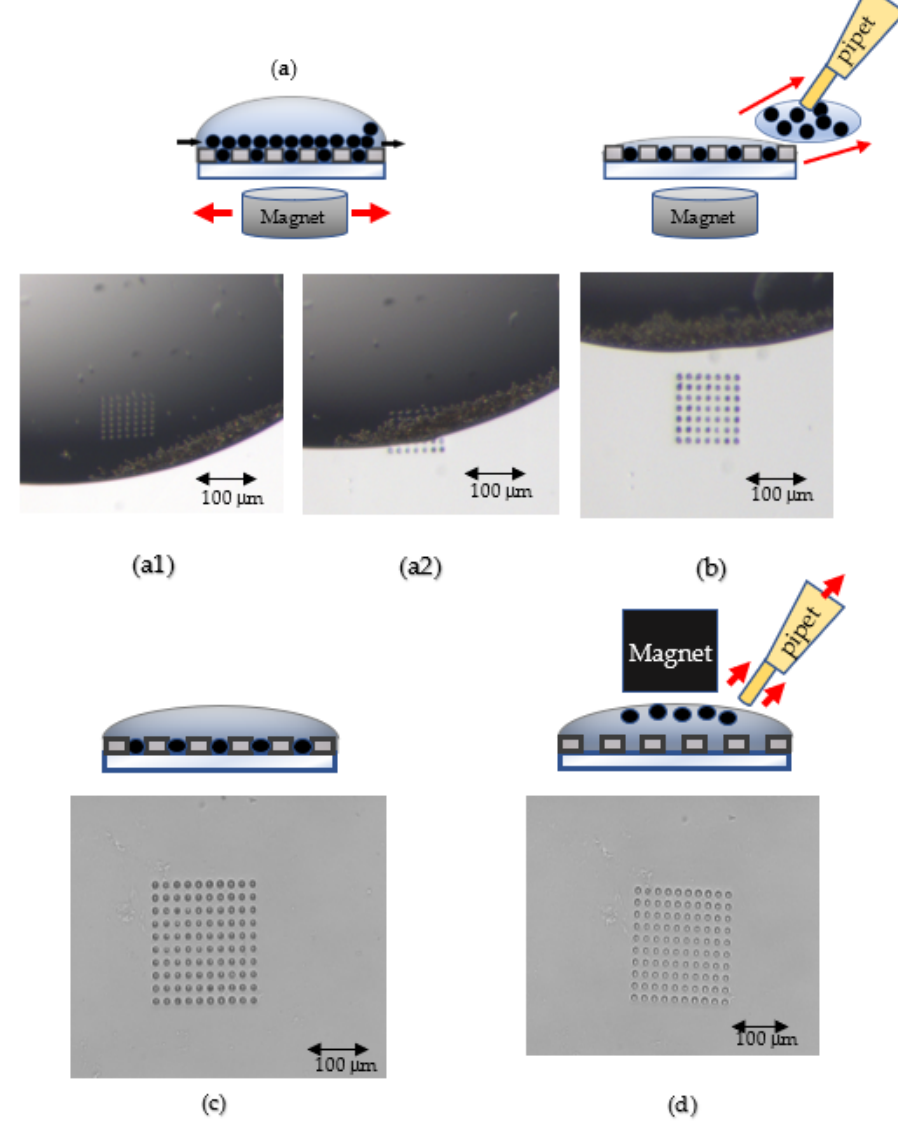
Figure 2. Obtaining the specified bead number on the bead screening chip. ( a ) Move the bead droplet and magnet to fill the wells with beads: ( a1 ) Drag the bead droplet towards the wells; ( a2 ) Move the droplet and magnet backward and forward to fill the wells with beads. ( b ) Remove excessive beads with liquid by a pipet. ( c ) Every well was filled with exact one bead; ( d ) Use a magnet to attract the beads to the droplet top surface and then retrieve the droplet with all beads by a